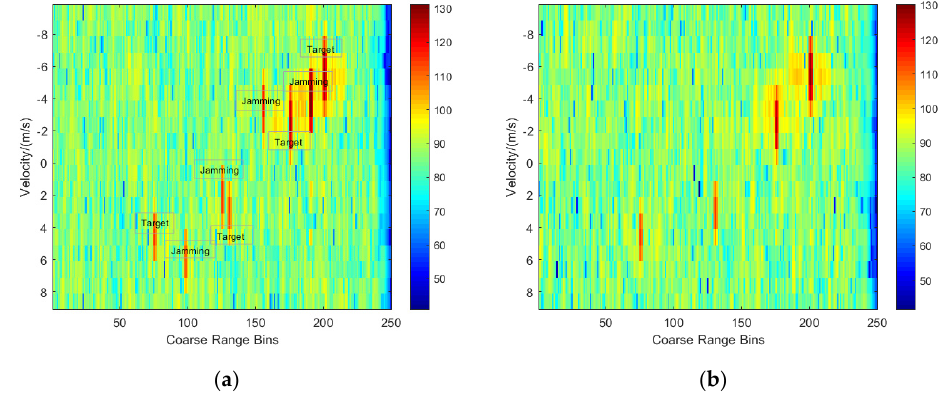
Figure 2. Echo plane after matched filtering. ( a ) Frequency non-agile case; ( b ) Frequency agile case